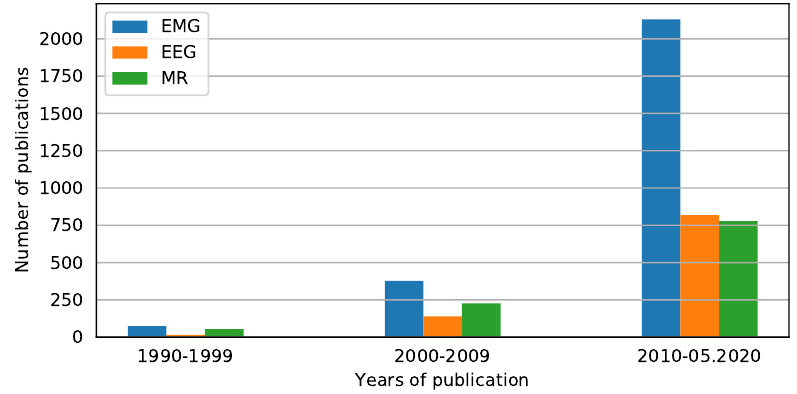
Figure 6. Publications on bionic orthosis control